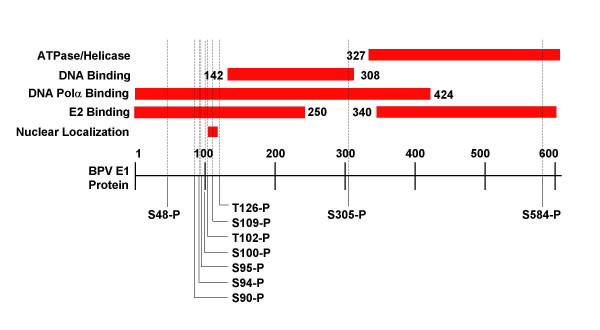
Positional phosphate map and functional domains of the BPV E1 protein. The 605 amino acid protein is represented on the lower horizontal line. The position of each of the phosphorylated amino acids is shown below. Functional domains are represented by the solid bars above. Functional domain boundaries in most cases were determined by deletion mutagenesis analysis as described in [10] and references therein.